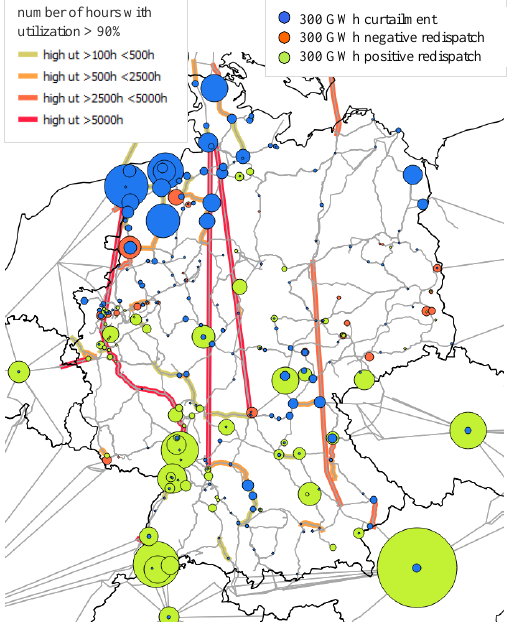
Figure 9. Lines in Germany with high utilization in the REF case and year